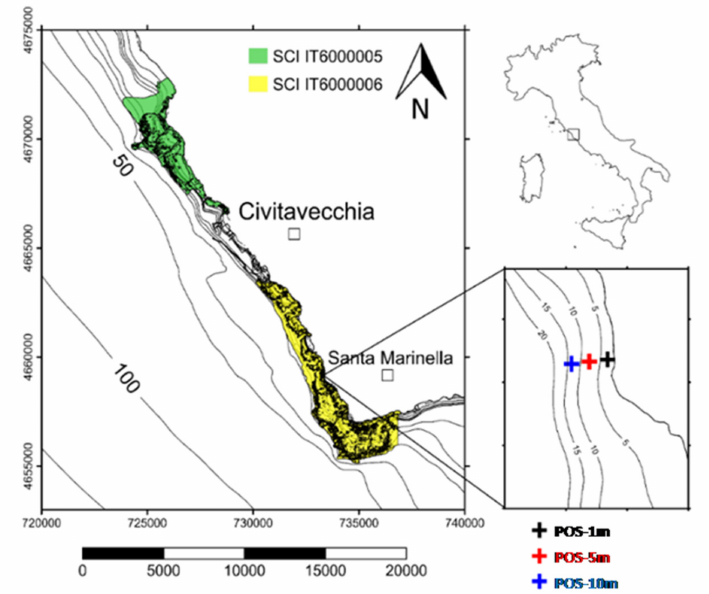
Figure 1. The study area with a zoom on the sampling stations: POS-1m (black cross), POS-5m (red cross) and POS-10m (blue cross), at 1, 5 and 10 m depth,